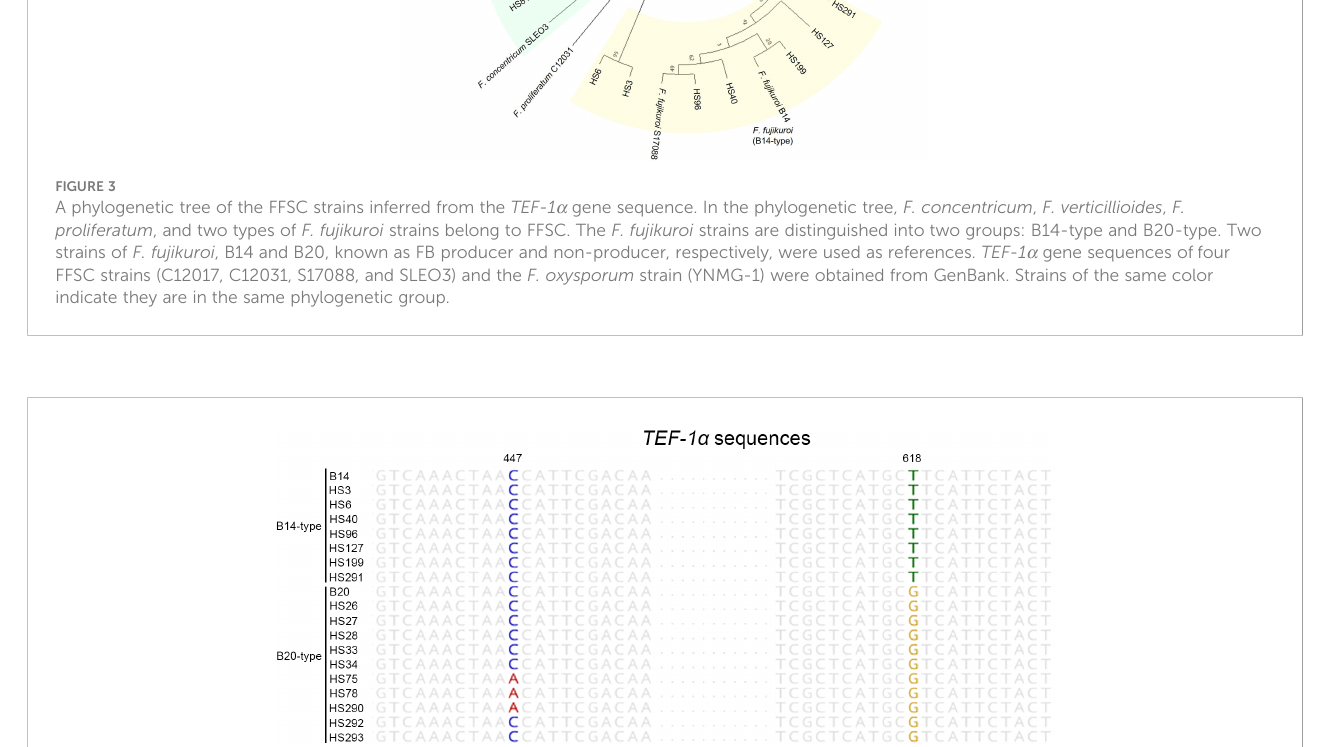
FIGURE 4 The nucleotide differences among aligned TEF-1 a gene sequences of F. fujikuroi strains. The aligned sequences show that the B14- and B20-type of F. fujikuroi have thymine and guanine at nucleotide position 618, respectively. Also, B14-type strains have cytosine at nucleotide position 447, however, the B20-type of F. fujikuroi has either adenine or cytosine at this